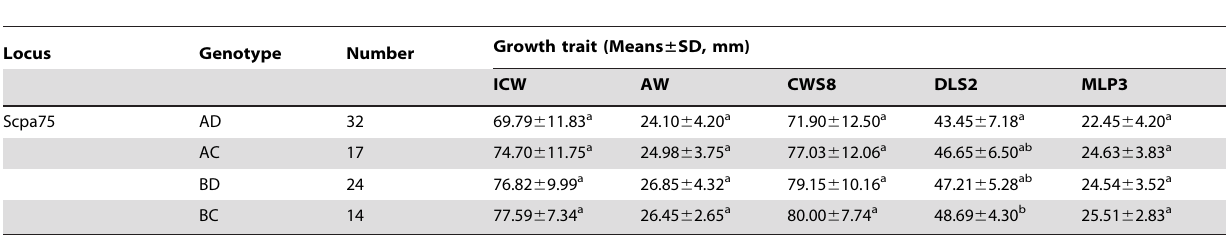
Table 3. Association analysis between microsatellite locus Scpa75 and five growth traits of S. paramamosain.